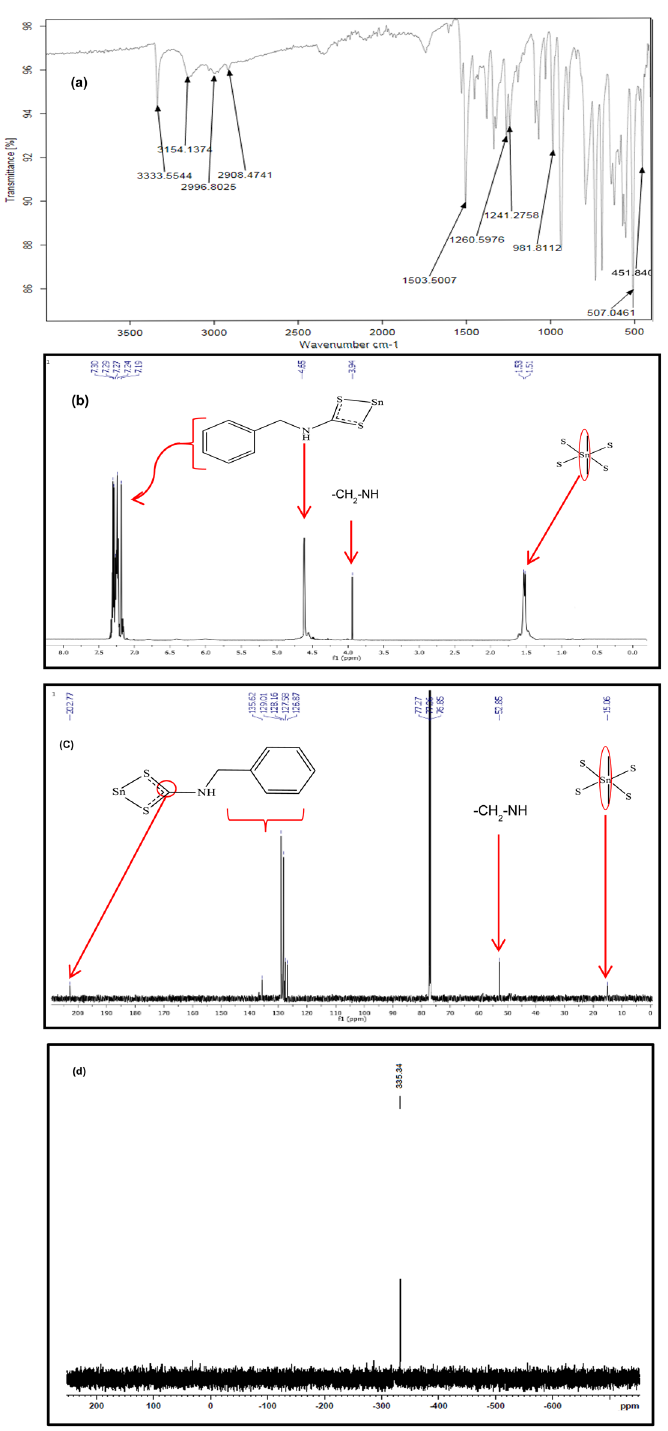
Figure 1: The ( a ) FTIR, ( b ) 1 H NMR, ( c ) 13 C NMR, and ( d ) 119 Sn NMR ( ppm ) spectra of [( CH 3 ) 2 SnL 2 ] ( 1 ) 2 emanating from the organotin ( 90 to 168°C and 122 to 171°C, respectively. These cause the respective mass losses of about 17.30% ( 1 ) and 10.43% ( 2 ) of found ( 1 : 82.70% and 2 : 89.57% ) at this stage were in close the starting masses. These mass losses have been attributed H group in complex 1 emanating from the to the two – C 6 5 ligand moiety and the mass of one – C H group in complex 4 9